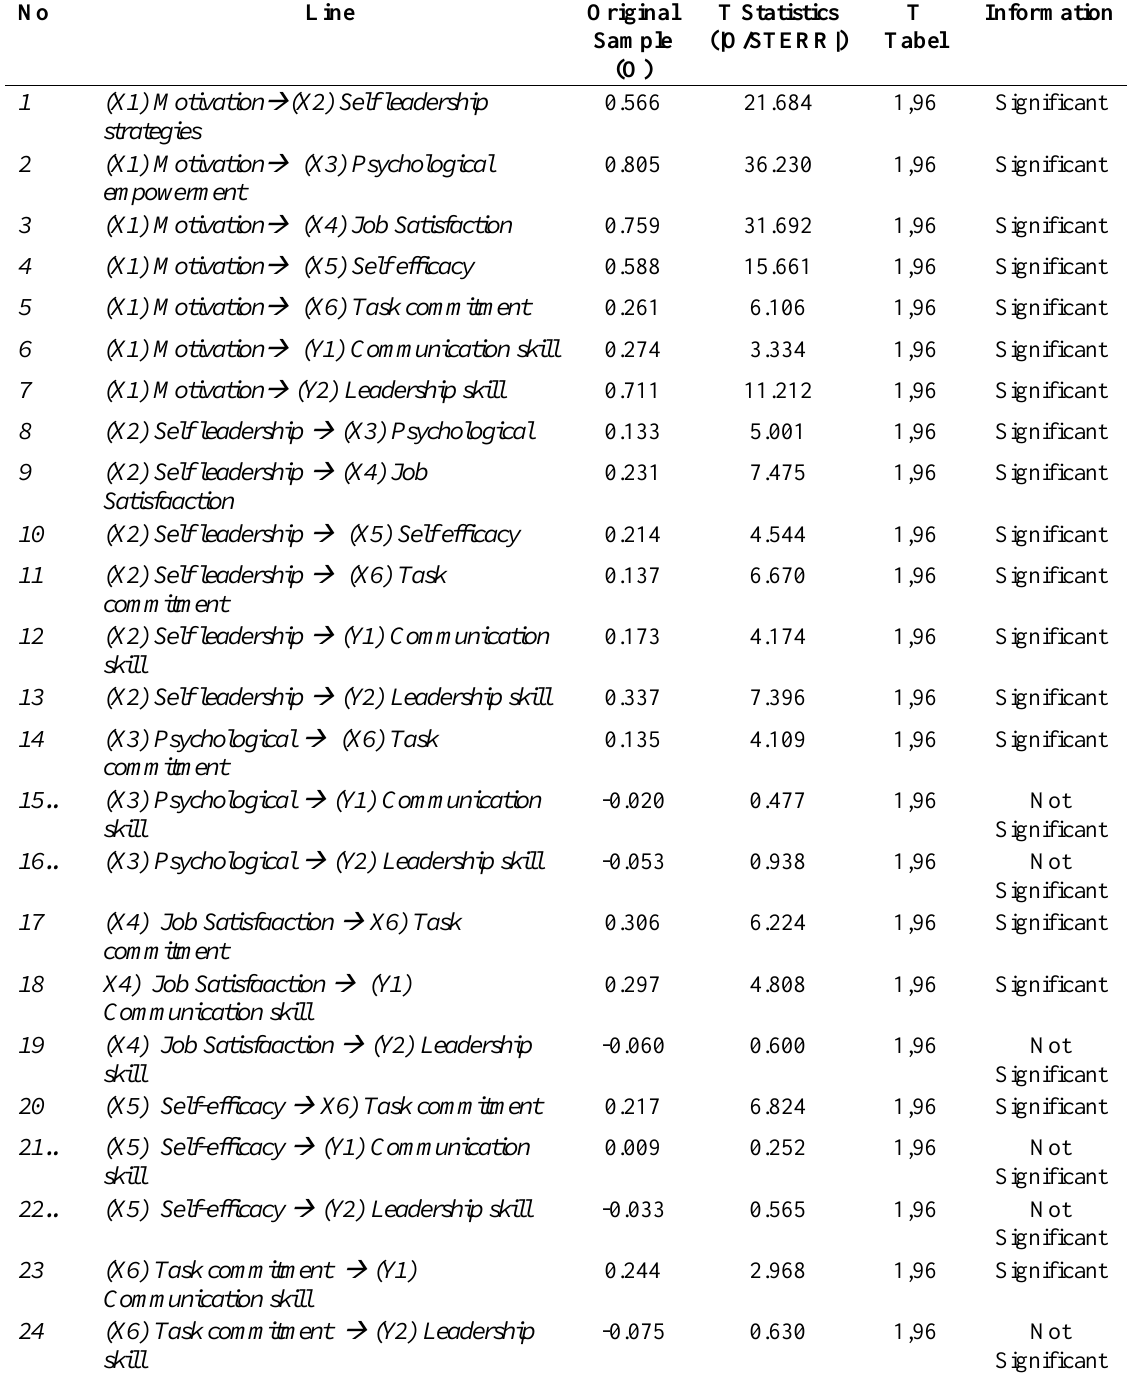
Table 1. T-Test Result of the Exogenous Latent Variable to the Endogenous variables and Line Coefficient Parameters in the Early Structural Model (Inner Model) No Line Original